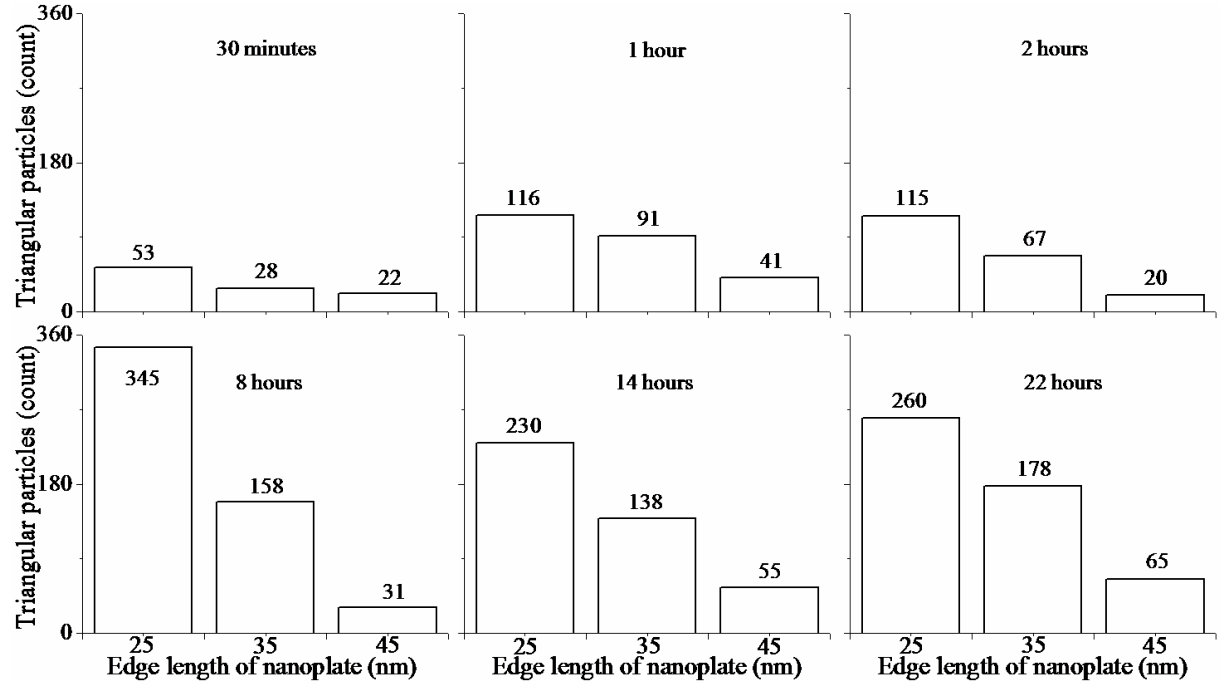
Figure 5. The edge length of triangular nanoplates on the surface for different exposure times. The edge length of 25 means the size of the nanoplates was from 20 to 30 nm, 35 from 30 to 40 nm, and 45 from 40 to 50 nm.